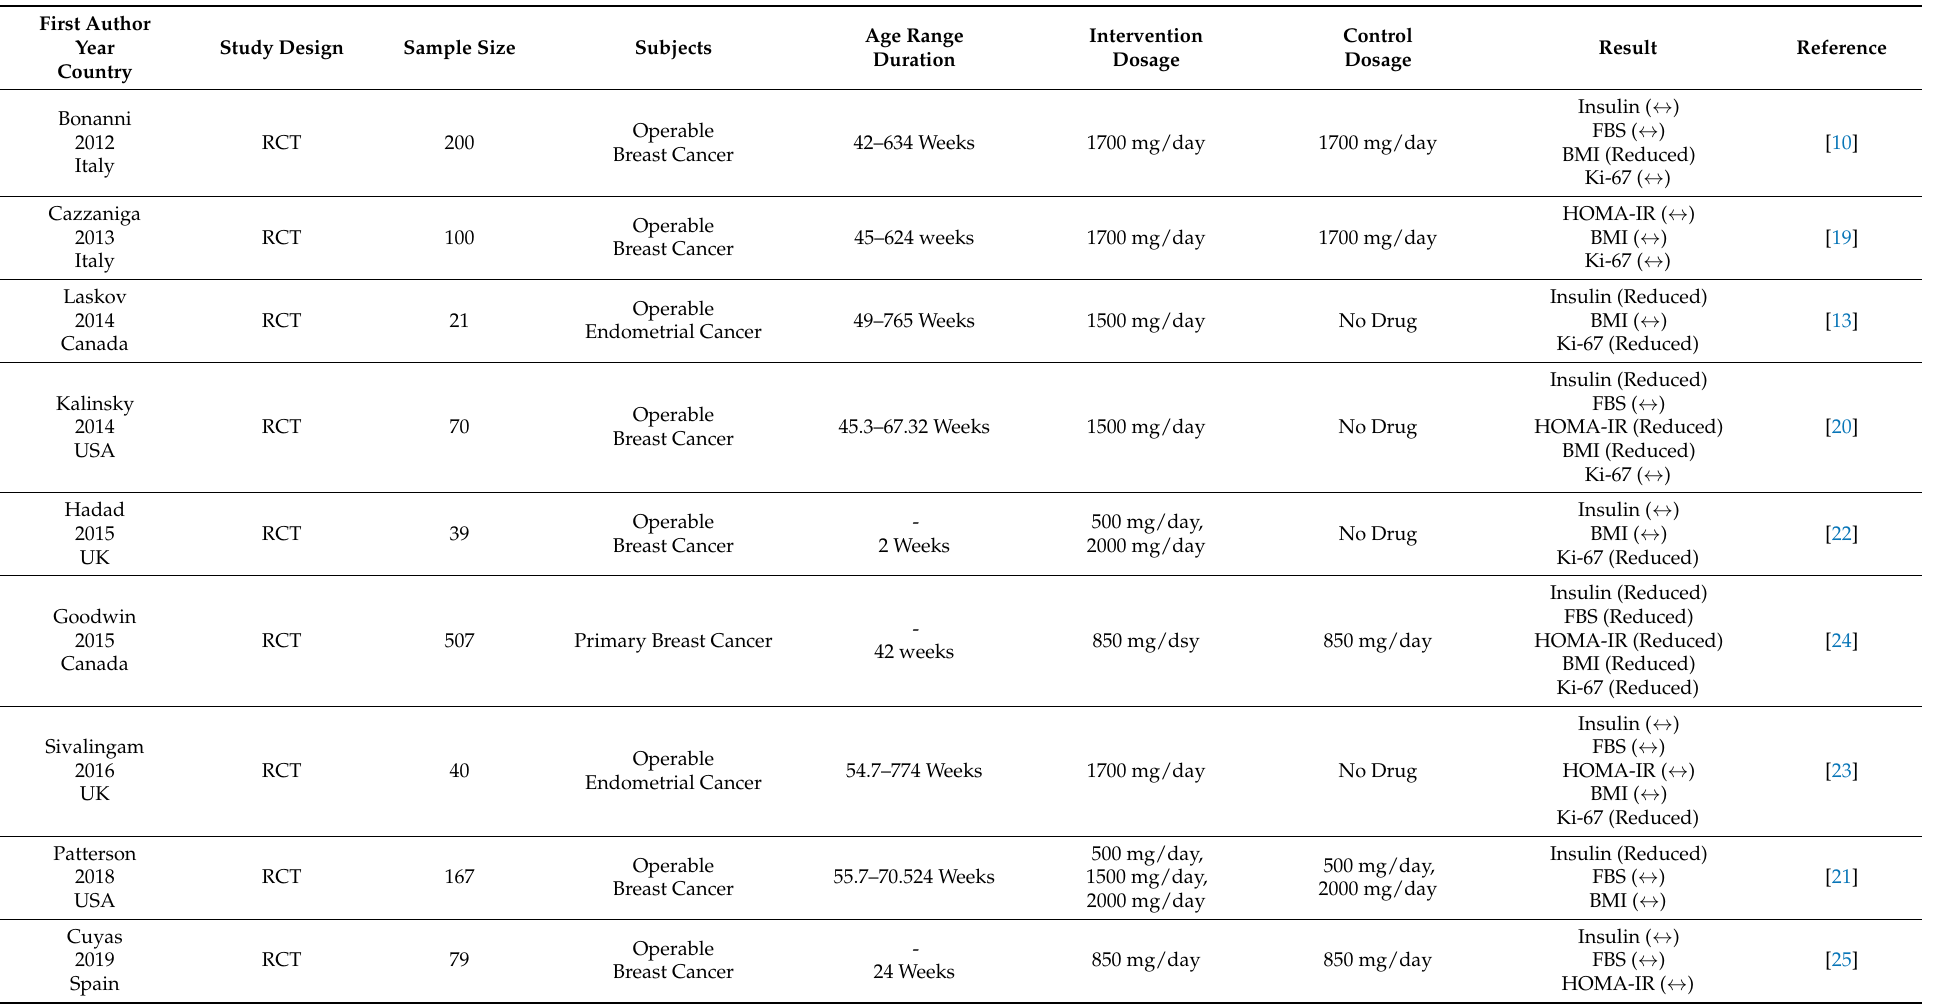
Table 1. Characteristics of the studies included in the meta-analysis and systematic review of metformin effects on cancer-related